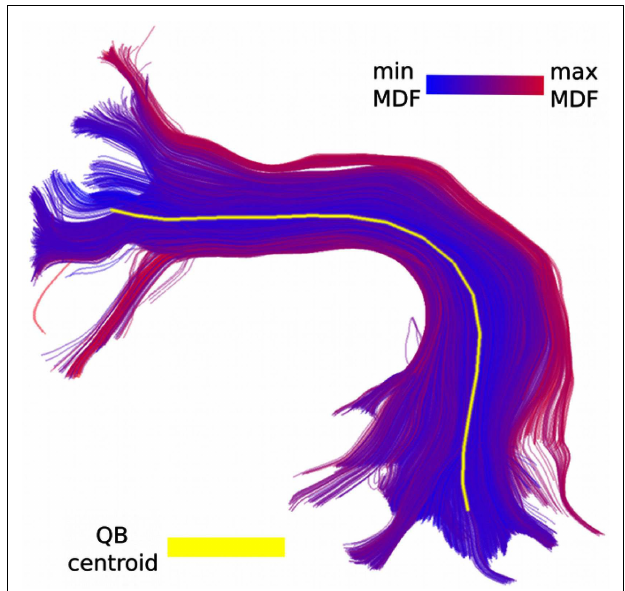
FIGURE 3 | Color coding shows MDF distances from QB centroid to every other track in the